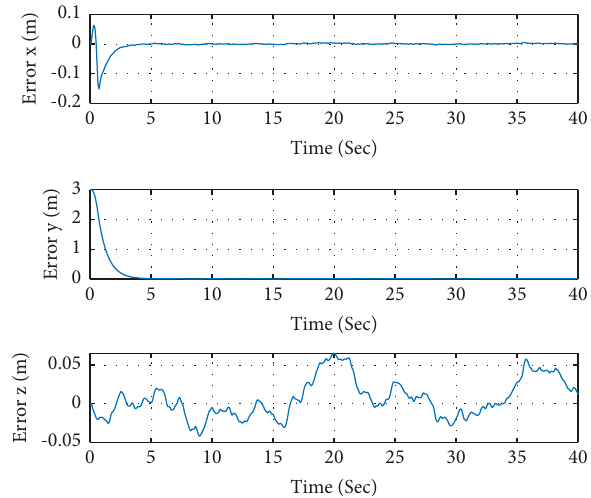
Figure 14: The trajectory tracking curve in 3D.